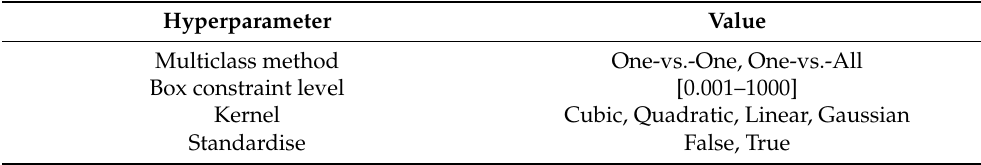
Table 1. Hyperparameter ranges tuned by Bayesian optimiser for SVM classifier.